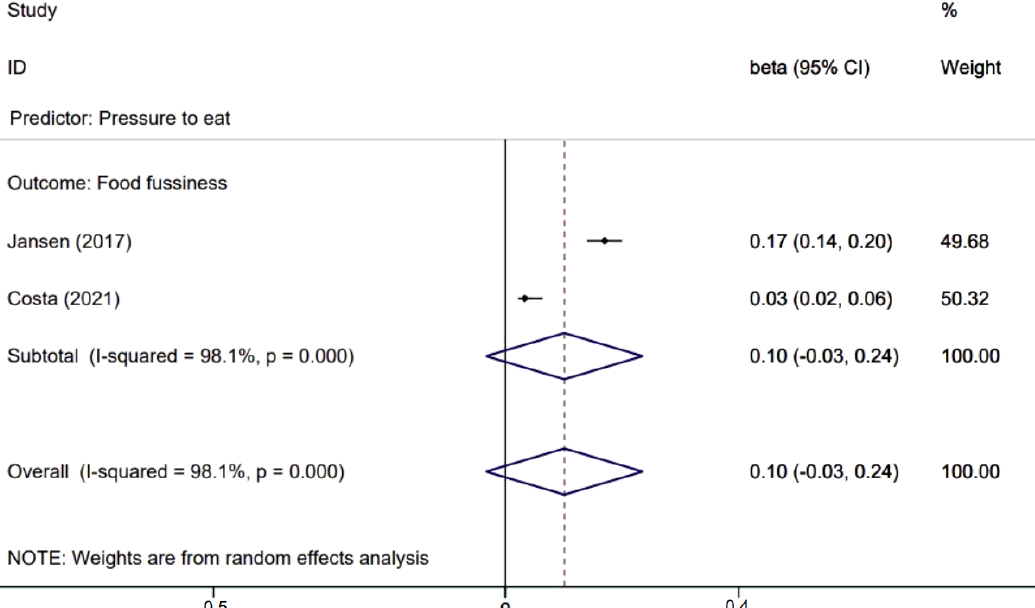
Figure 4. Effects of parental use of food as a reward on child eating behaviors.